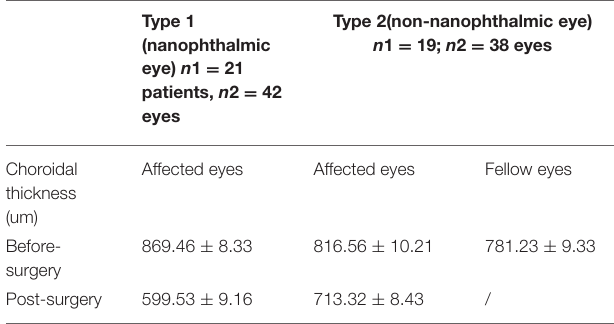
TABLE 3 | Change in choroidal thickness of patients with UES before- and post-surgery to the last follow-up visit available. Type 1